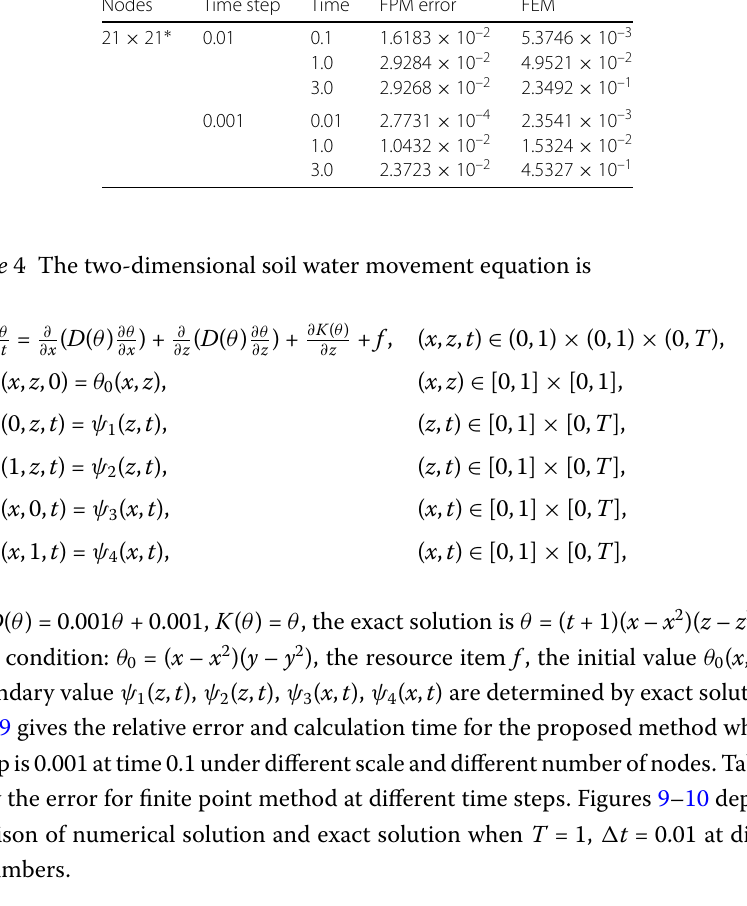
Table 10 Comparison of calculation results of FPM and FEM at different times Nodes Time step Time FPM